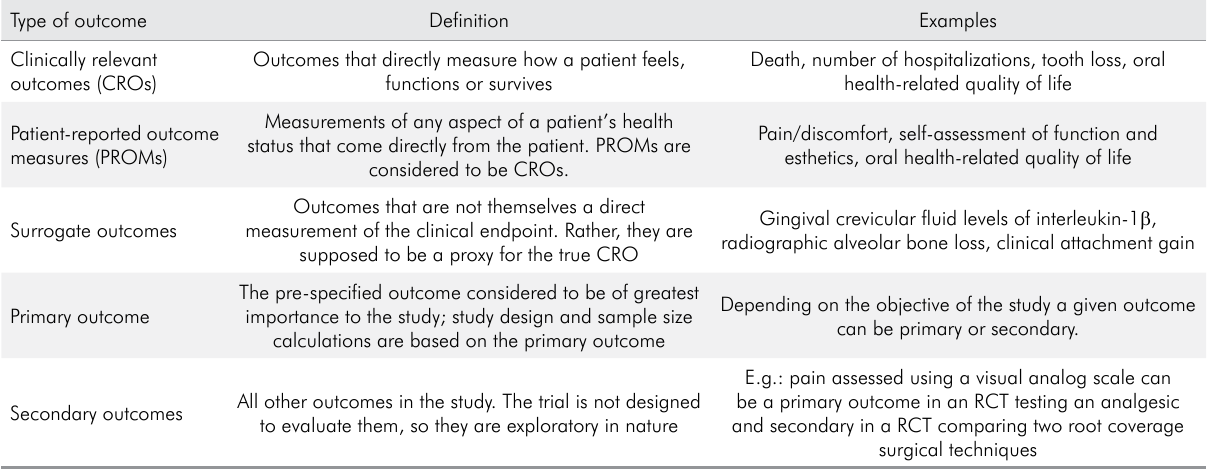
Table 2. Summary of concepts and